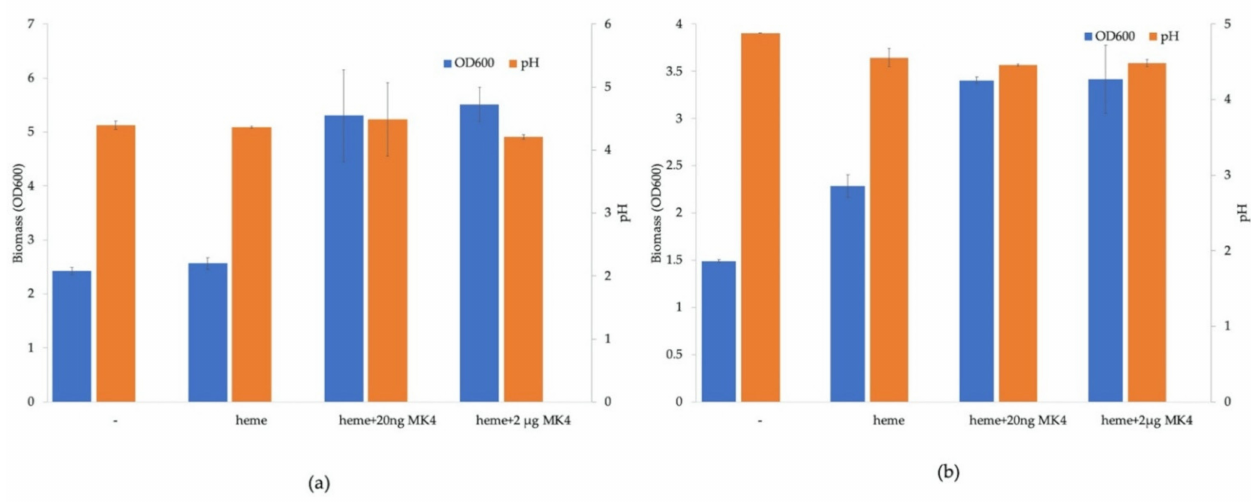
Figure 4. Lactipl . plantarum WCFS1 ( a ) and Lent . buchneri DSM 20057 ( b ) were grown aerobically for 24 h at 37 ◦ C in MRS medium without heme and menaquinone supplementation (-), with only heme supplementation (heme), and with heme and 20 ng/mL or 2 µ g/mL menaquinone supplementation (heme + MK4). The blue bars represent the biomass formation (OD 600 ), and the orange bars represent the final pH.